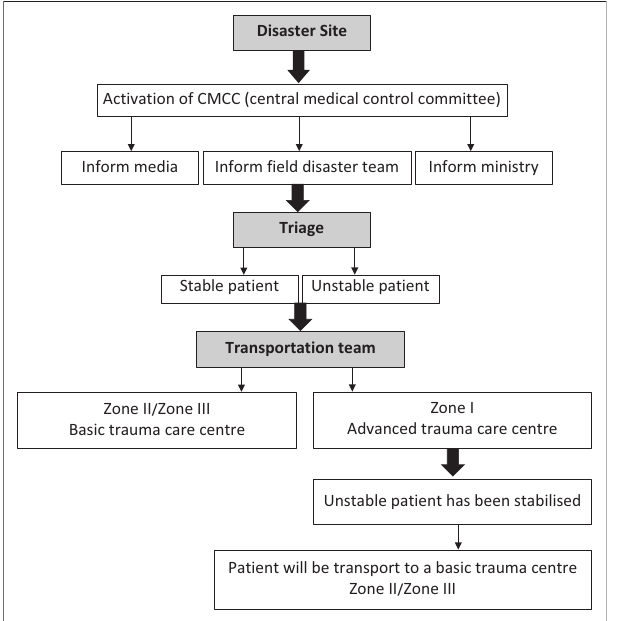
FIGURE 1: Disaster mitigation